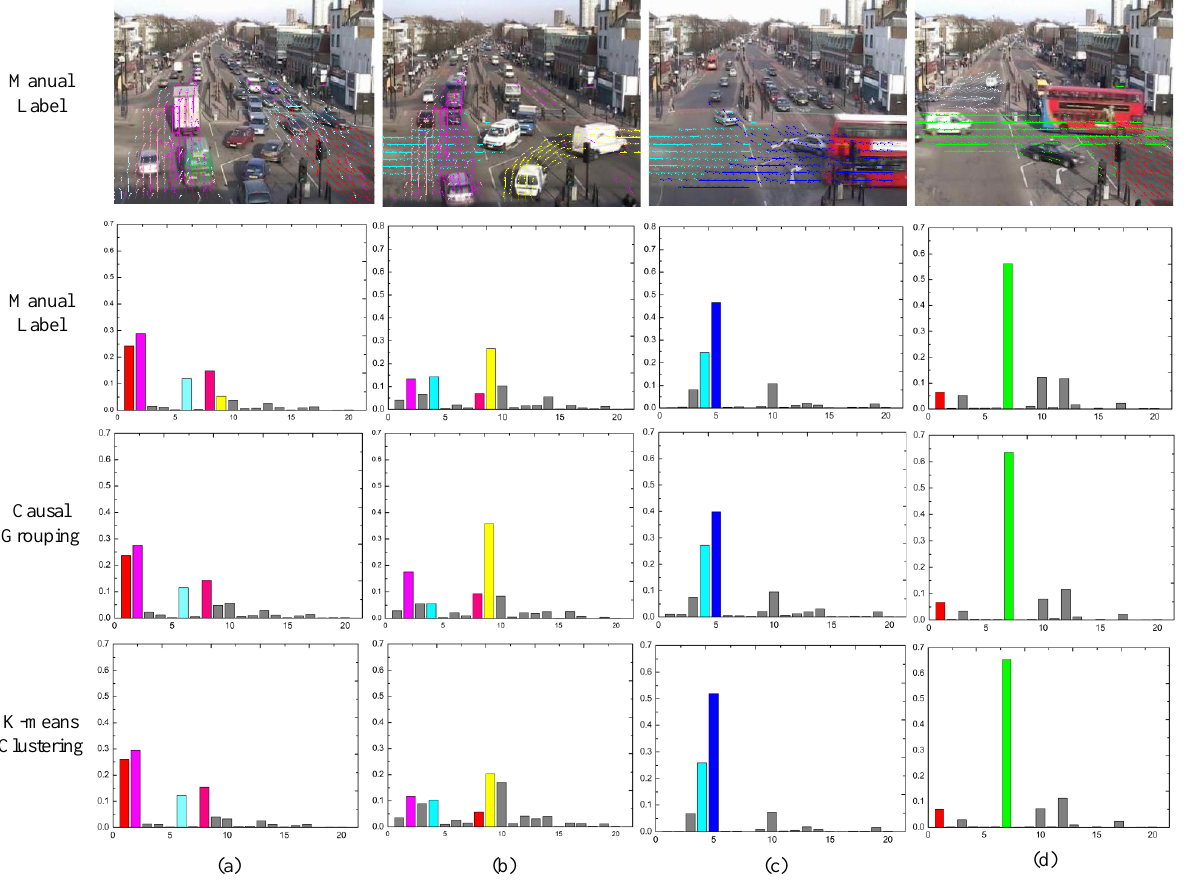
Figure 14. The topic distributions for the intersection dataset. The short video clips are grouped into four clusters. Different colors indicate the different topics